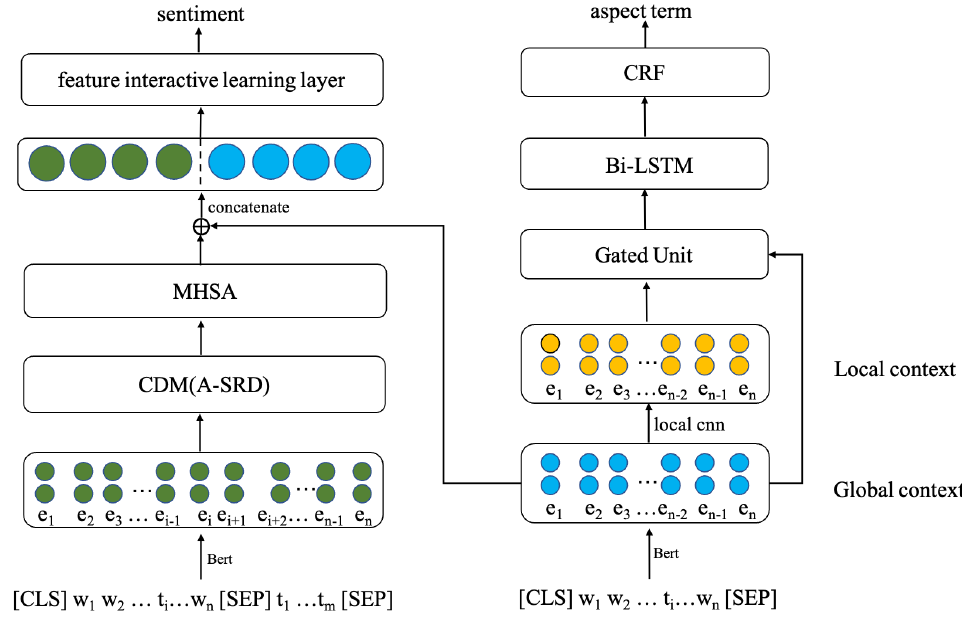
Figure 2. Overall structure of